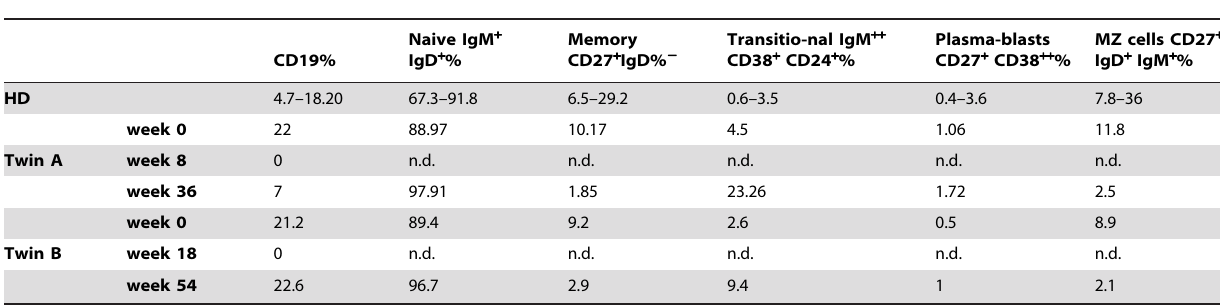
Table 1. B cell subpopulations distribution in response to rituximab